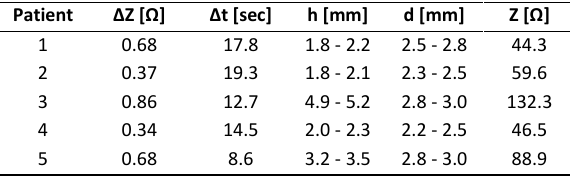
Fig. 8: The impedance signals obtained by electrode system. Table 3: The numerical characteristics of the impedance